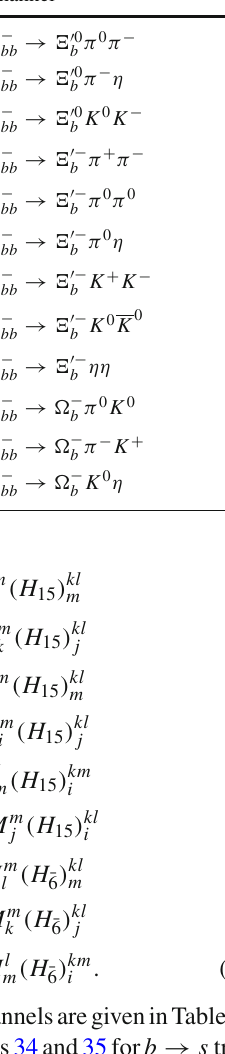
Table 25 Doubly bottom baryon decays into a bqq (sextet) induced by the charmless b → d transitionand two light mesons